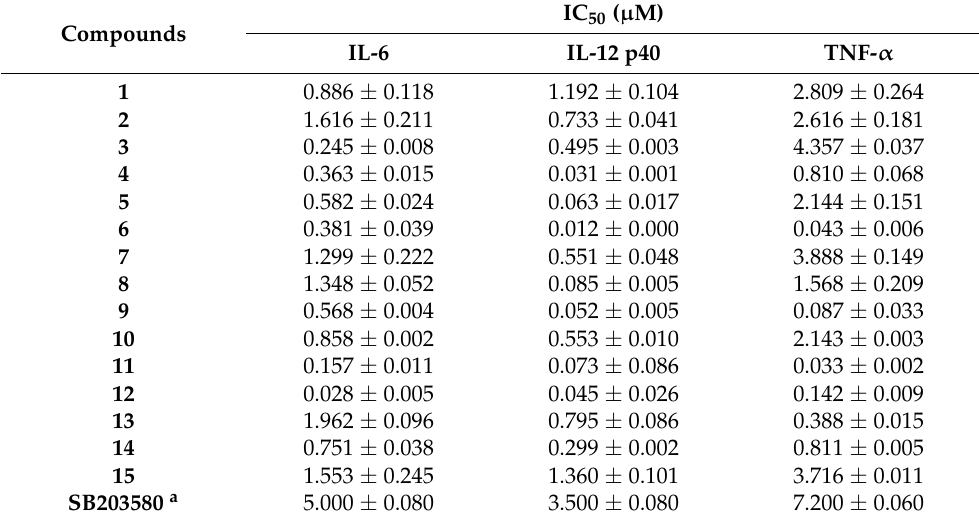
Table 1. Inhibition of isolated cucurbitane-type triterpenoids ( 1 – 15 ) on IL-6, IL-12 p40, and TNF- α production in LPS-stimulated bone marrow-derived dendritic cells.